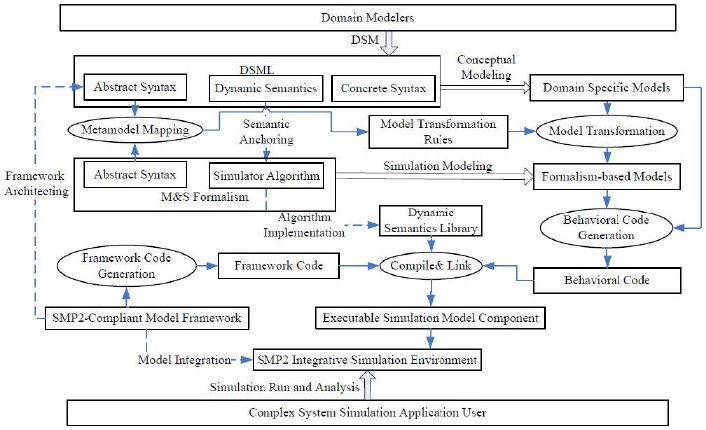
Fig. 4 System layer simulation block